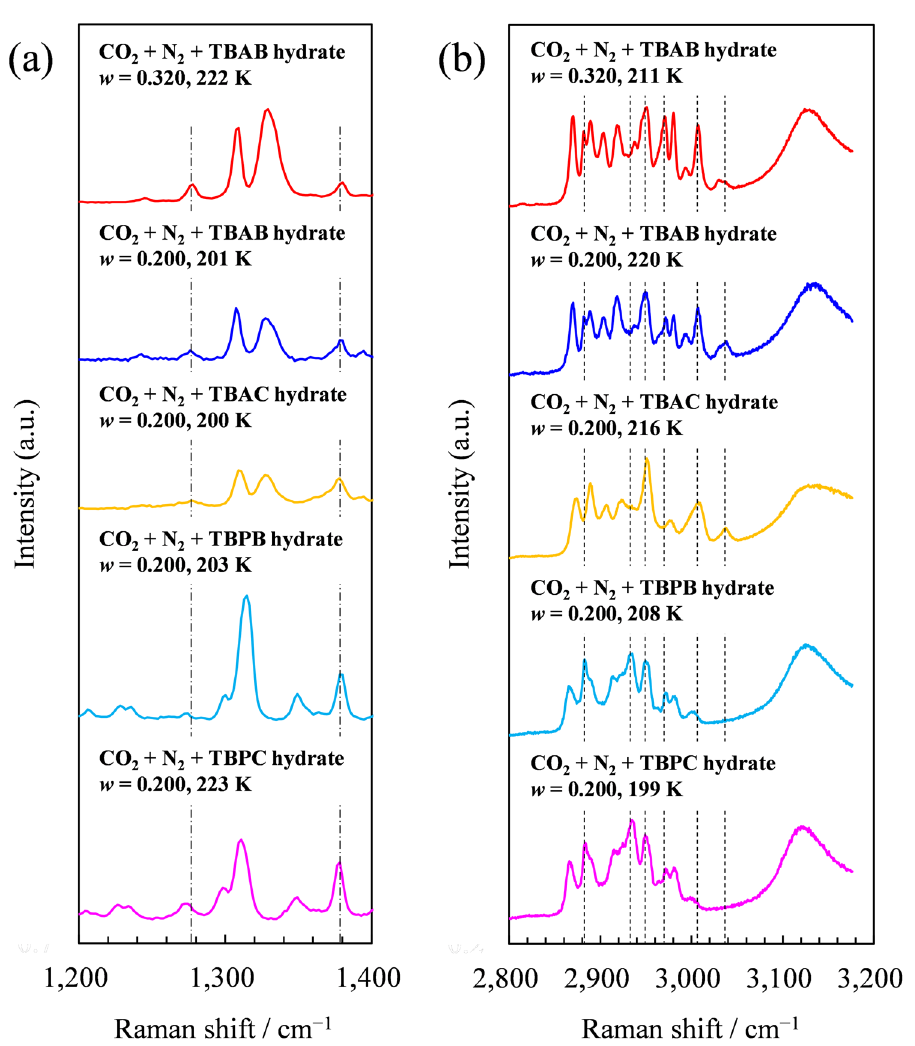
Figure 6. Raman spectra of the ionic clathrate hydrates formed with CO 2 + N 2 gas. Spectra were collected under N CO 2 peaks at 1278 and 1380 cm − 1 . Dashed lines indicate the peaks of C–H stretching vibration modes of TBA + and/or TBP + at 2884, 2937, 2947, 2969, 3009 and 3040 cm − 1